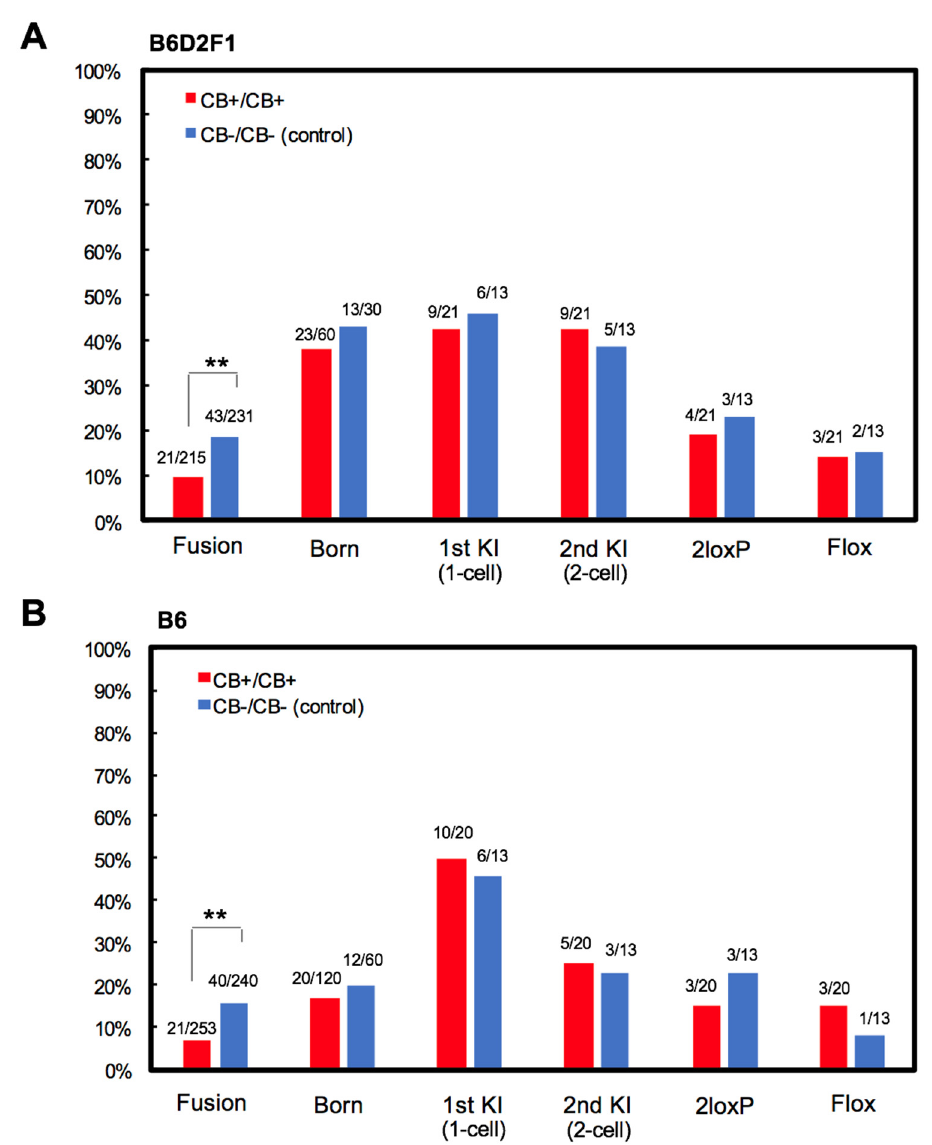
Figure 5. Effects of CB treatment on 2-cell embryos treated with sequential EP in vivo. Fusion rate, birth rate (born/ET), and KI efficiency after sequential EP were measured in both ( A ) B6D2F1 and ( B ) B6 mice. 2loxP = mice with two loxP sites in cis or trans; flox = mice with two loxP sites in cis. ** p < 0.01.